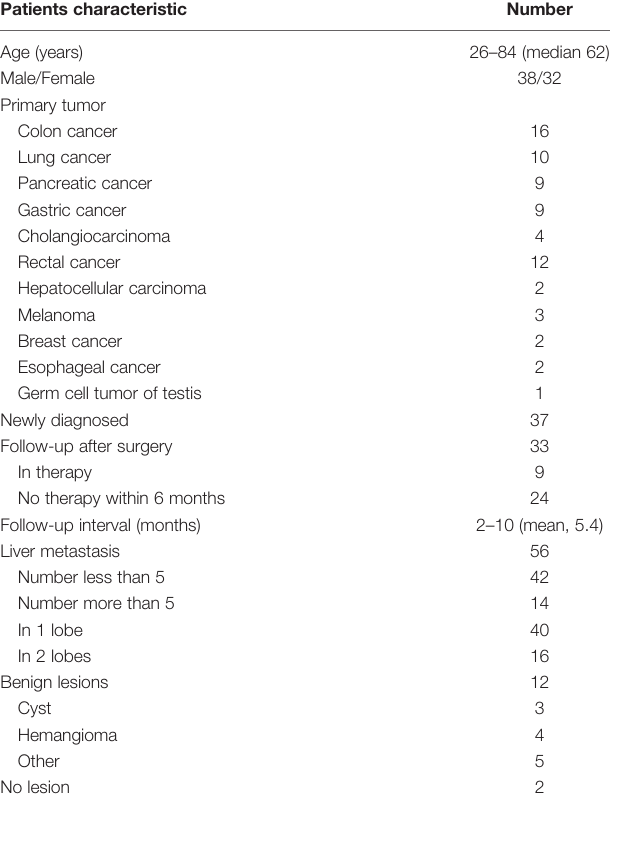
TABLE 2 | Patient characteristics.